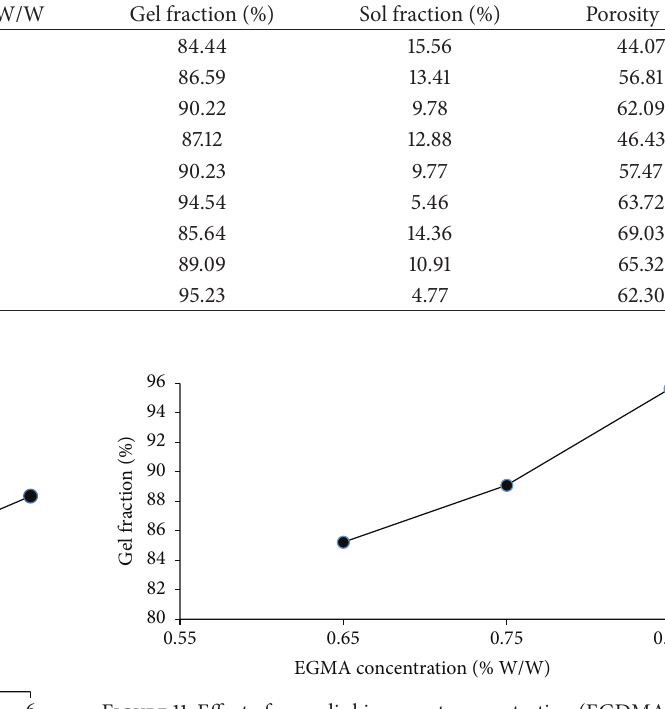
Figure 11: Effect of cross-linking agent concentration (EGDMA) on gel fraction of AA/Gelatin hydrogels.